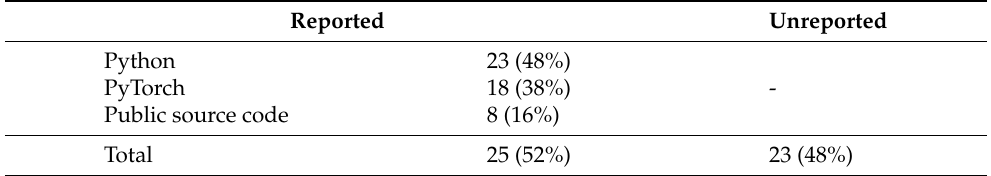
Table 4. Papers’ distribution with respect to reporting details on the implementation techniques.